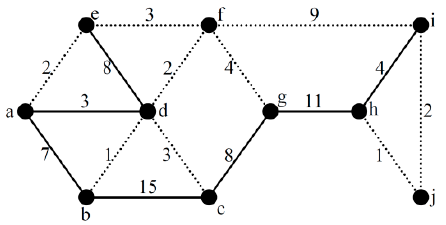
Figure 4. Example of graph spanning tree (result is marked by dotted line).